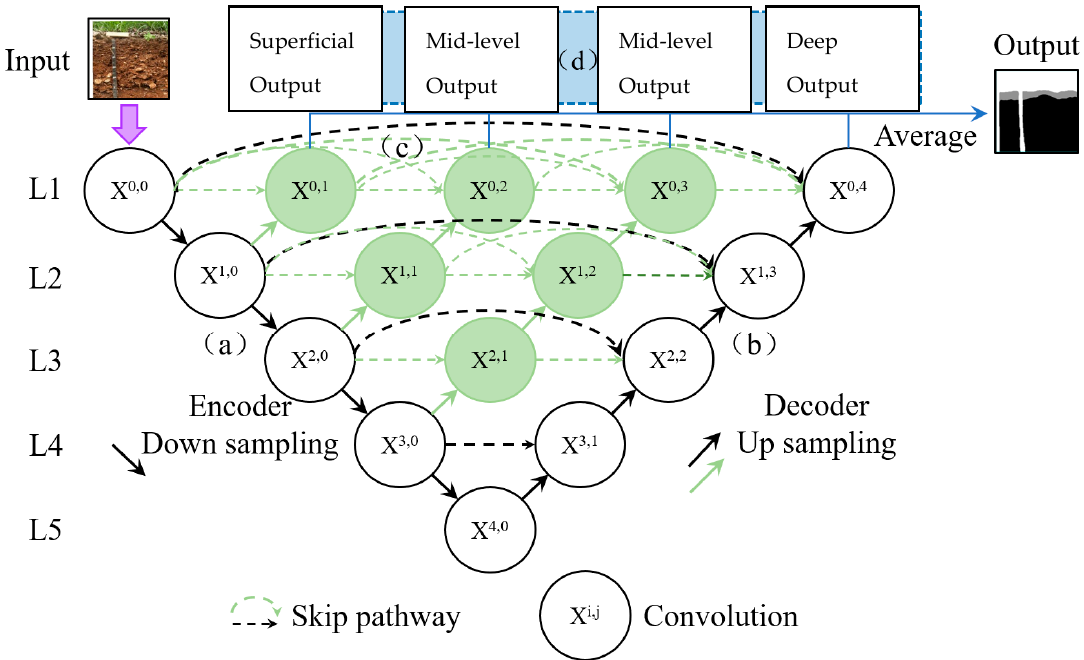
Figure 8. Architecture for UNet++. The purple part represents the input of the preprocessed image. The black part represents the architecture of the classical semantic segmentation network UNet. The green part represents the densely nested skip paths in the UNet++ network, which is also the improved part for the UNet. The blue part represents the final process of averaging the results of the output of the various layers of the network at different depths. Adapted from Reference